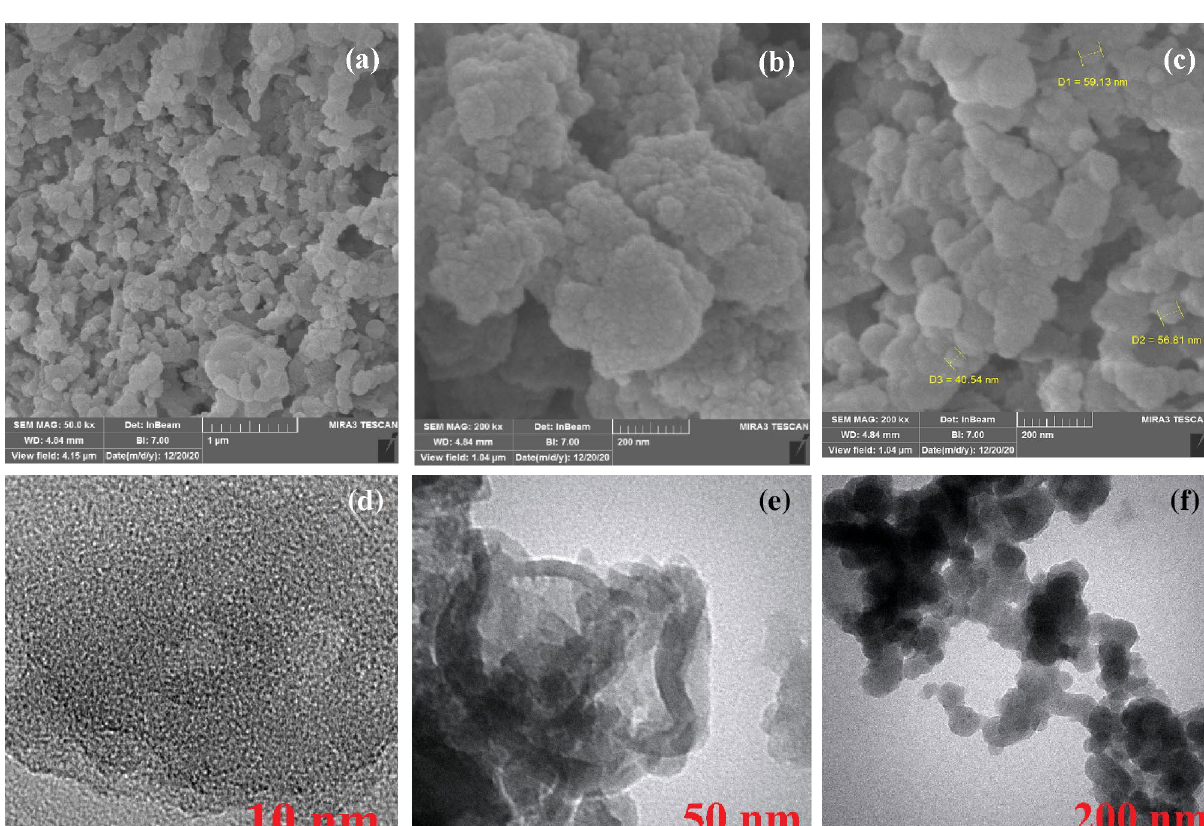
Figure 4. FESEM ( a – c ) and TEM images ( d – f ) of the Cu@APS-TDU-PMO nanoreactor ( 1